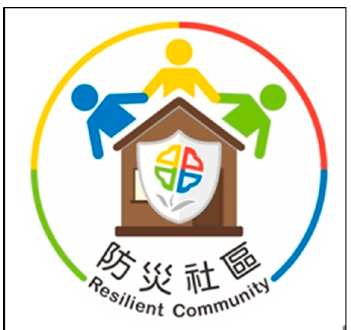
Figure 7. NTPC Resilient Community Certificate.